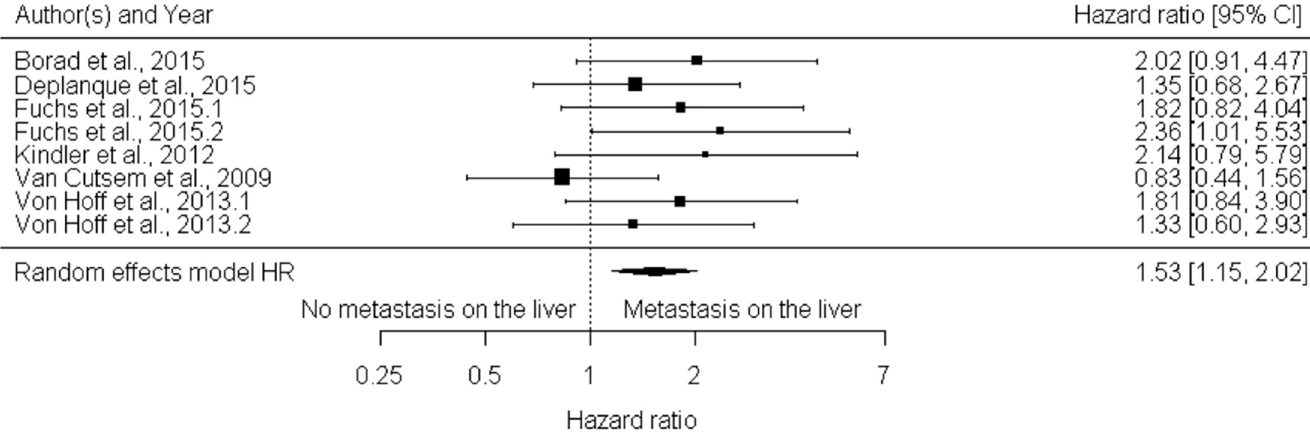
Fig 3. Forest Plot for risk of death and liver metastasis based on hazard ratios (N = 2633). Overall the presence of hepatic metastasis increases the risk of death around 50% (HR1,53 CI 95% [1,15; 2,02] (p 0,003).